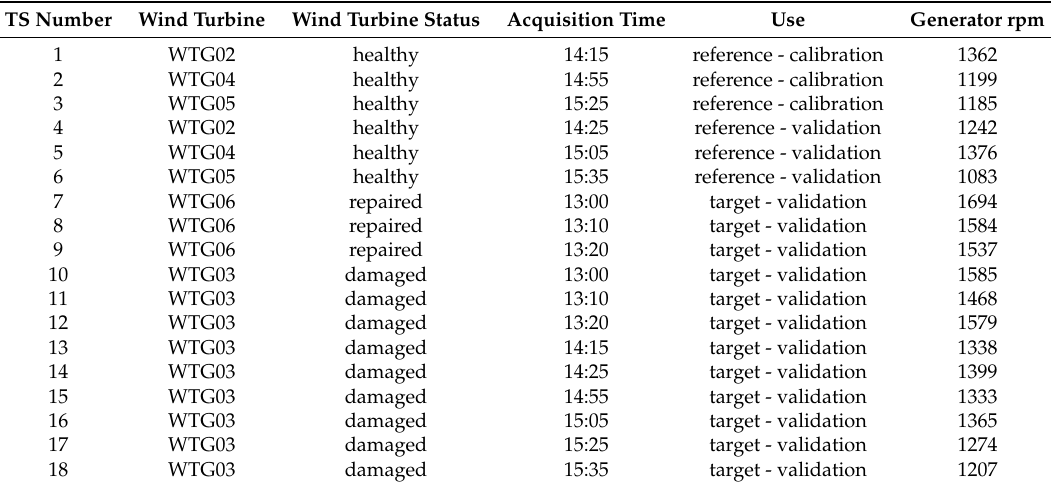
Figure 2. Definition of the reference frame for the longitudinal and the transversal directions. Table 1. The time series